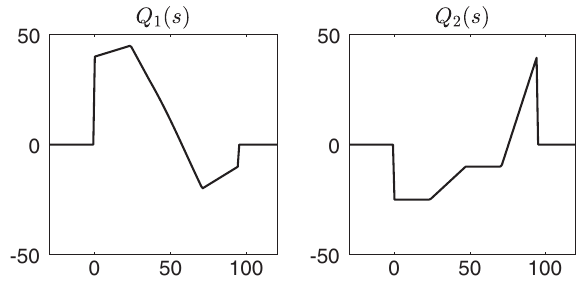
FIG. 7. The designer Q 1 and Q 2 (in m − 1 ) versus the path length (in mm) as used in the verification test. These curves have been chosen arbitrarily and are piecewise smooth inside the inflector.